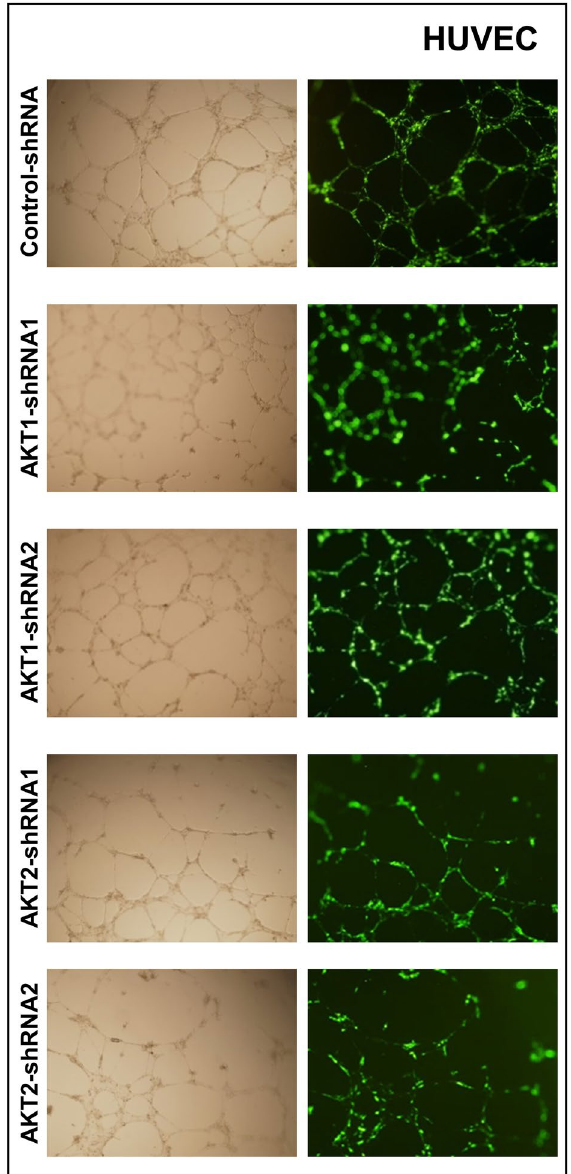
Figure 1. Corrected panel 7A: Formation of capillary-like structures by human umbilical vein endothelial cells (HUVECs) transduced with control-shRNA, two different design of AKT1 shRNA (Akt1-shRNA1 and Akt1-shRNA2) and two different design of AKT2 shRNA (Akt2-shRNA1 and Akt2-shRNA2) and cultured on Matrigel matrix in 96-well